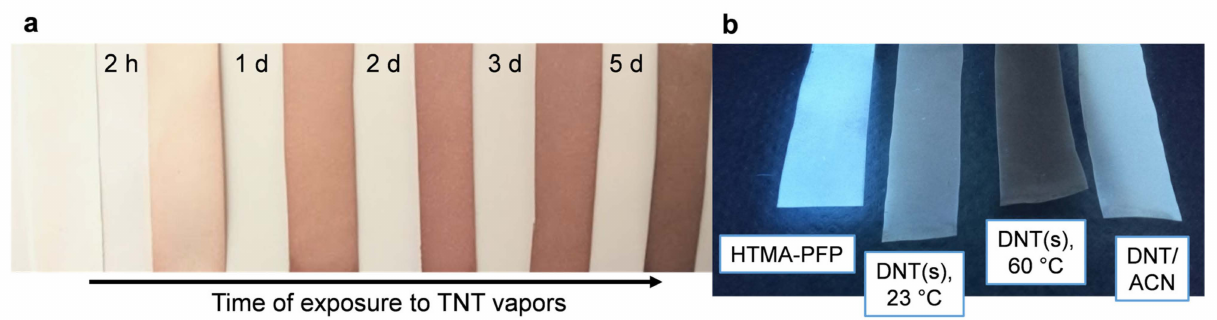
Figure 2. Photographs of: ( a ) PDMAEMA-impregnated paper for TNT, the first of which was not in contact with the analyte, whereas each of the other samples has its exposure time indicated at its left; ( b ) HTMA-PFP-impregnated paper-based probes for DNT under radiation at 366 nm, where the sample at the left had not been in contact with the